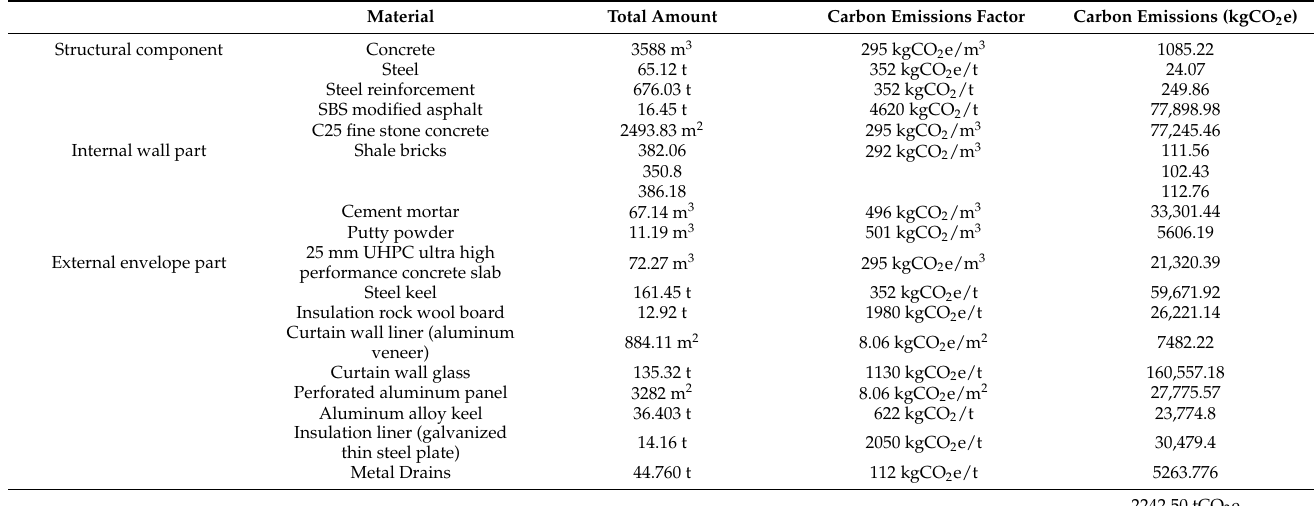
Table 17. Calculation of carbon emissions in site